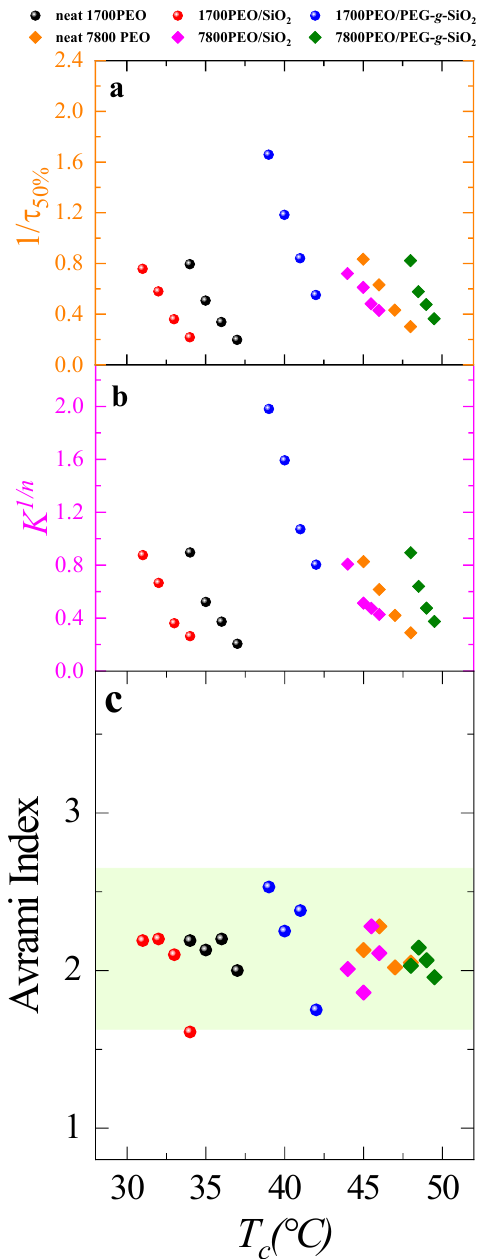
Figure 6. ( a ) The inverse of half crystallization time 1/ τ 50% as a function of crystallization tempera- ture, T c . ( b ) K 1/n as a function of T c . ( c ) Avrami index n as a function of crystallization temperature, T c .